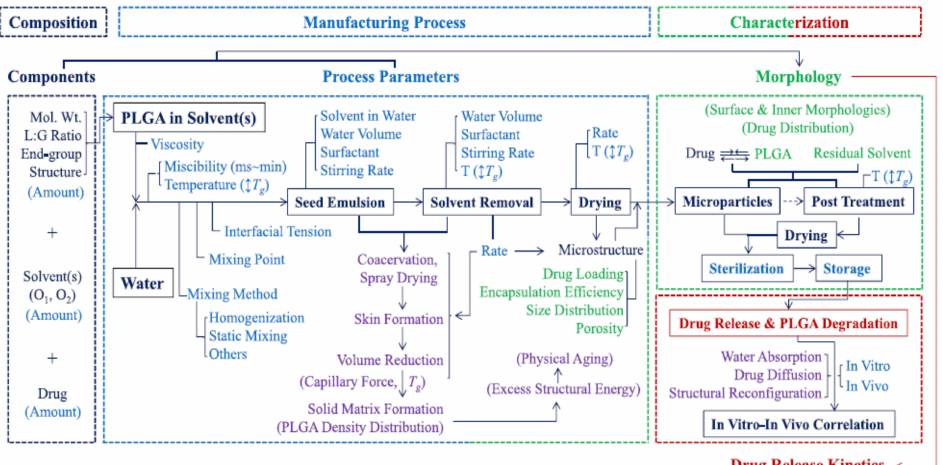
Figure 3. Manufacturing process of PLGA microparticles by emulsion methods and the parameters affecting the final properties of the formulation. Reprinted with permission from Ref. [112]. Copyright 2021,